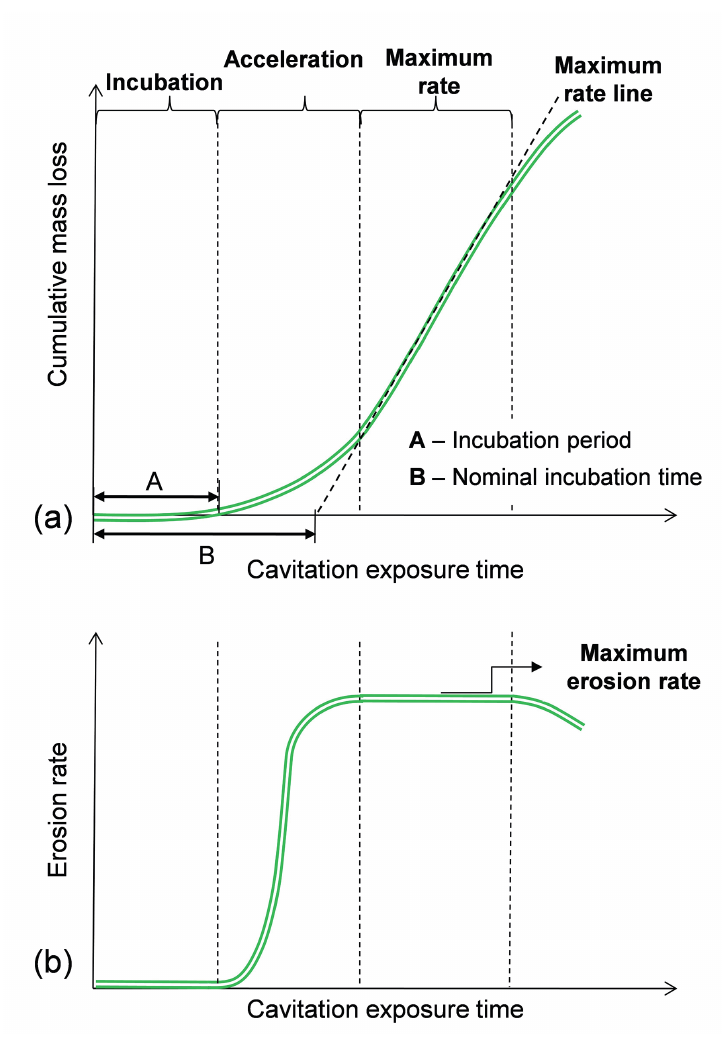
Figure 1: Characteristic curves of cumulative mass loss and erosion rate vs. cavitation exposure time. The three initial stages of cavitation are identified: incubation period, acceleration period and maximum rate period. Nominal incubation time is also